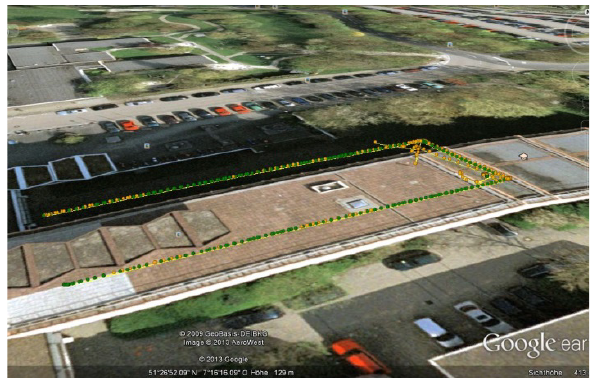
Figure 10. Kinematic RTK measurements on the roof of the test building (green: fixed solution, orange: float